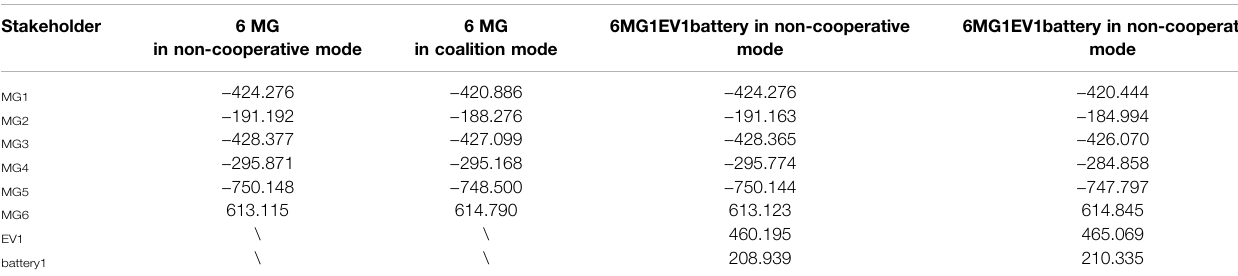
TABLE 3 | total daily operation gains of every stakeholder (unit: CNY).